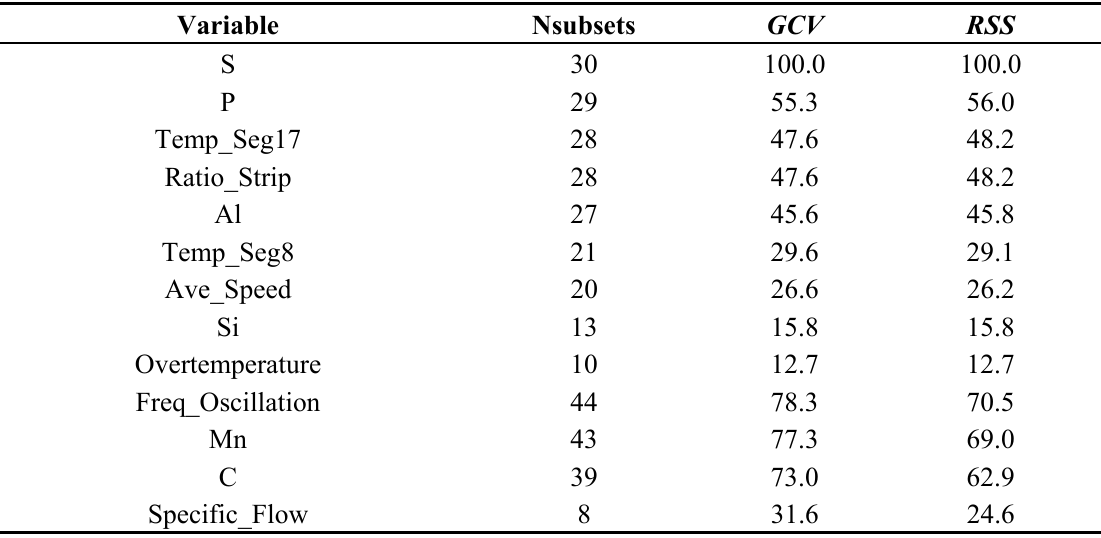
Table 5. Evaluation of the importance of the variables that form the model for the Average Width of the spots according to criteria Nsubsets, generalized cross-validation ( GCV ) and residual sum of squares ( RSS